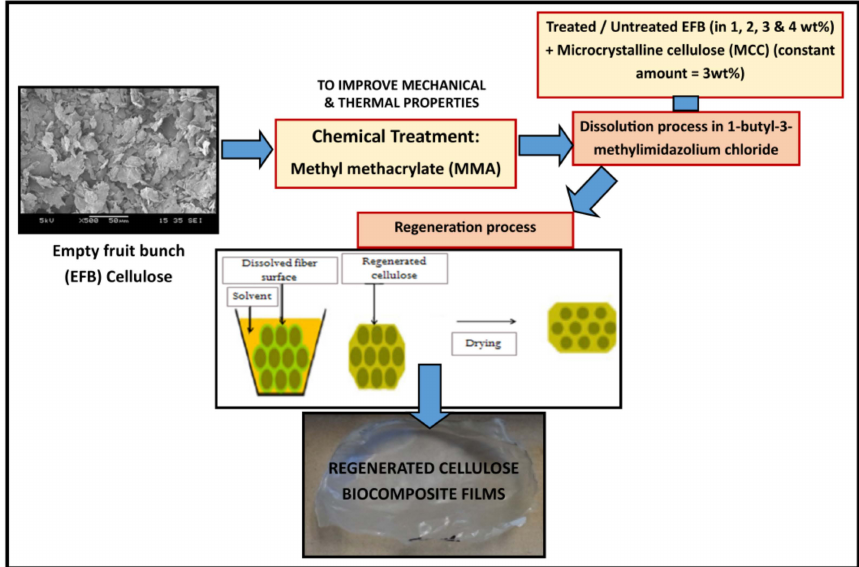
Figure 1. Procedures to prepare EFB RC biocomposite